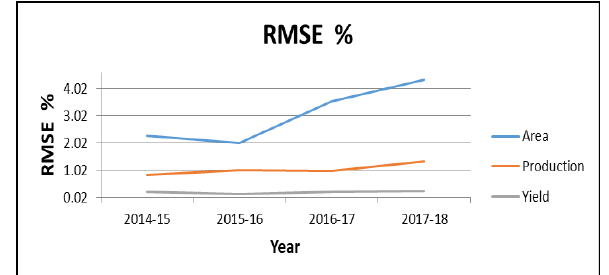
Figure 10: Coefficient of determination for area, yield and